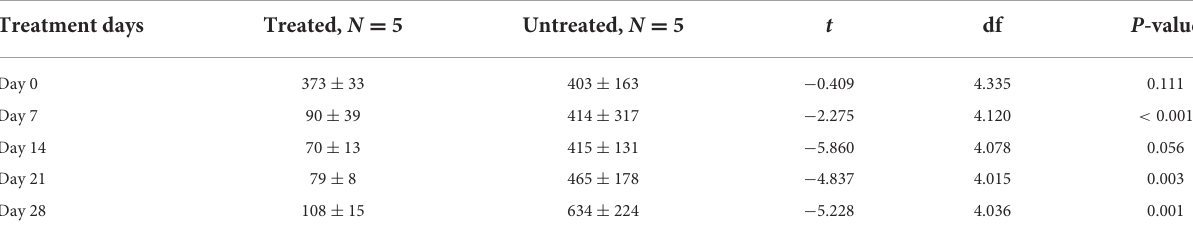
TABLE 6 Effect of ivermectin treatment on sheep lice infestation, mean lice count among treated and untreated group in Sayint district, South Wollo, Ethiopia. Mean lice count ± SD